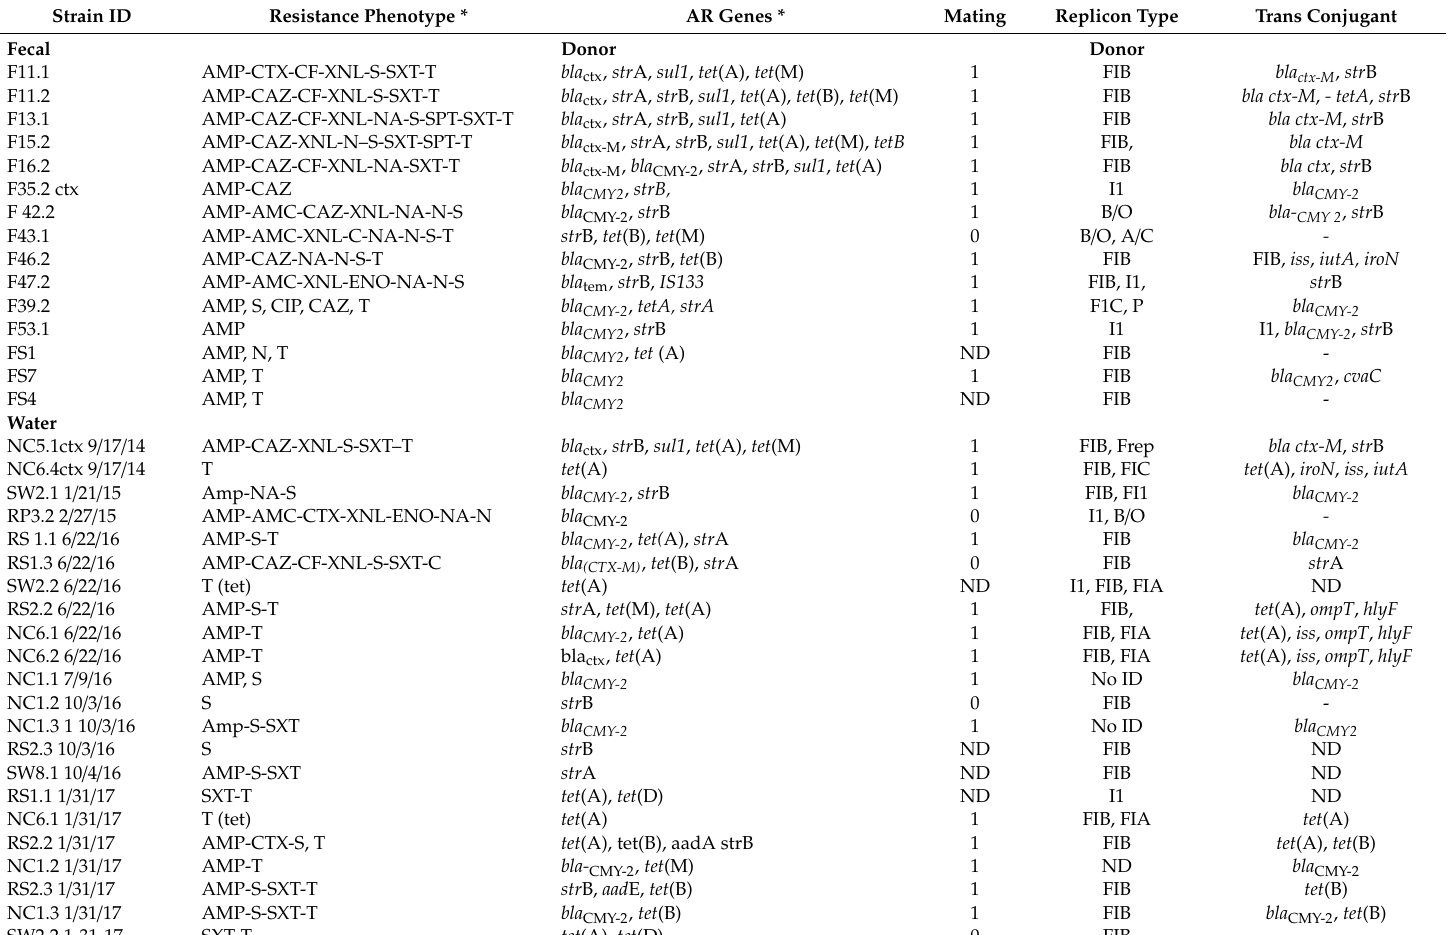
Table 3. Antibiotic Resistance Pattern of Donors and